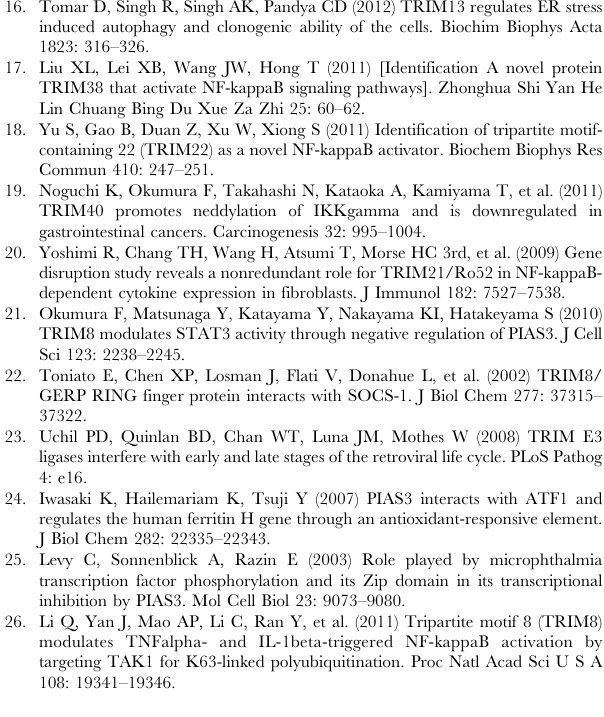
loaded for negative control of HA-TRIM8 and p65-GFP. Figure S3 TRIM8 overexpression increases clonogenic ability of HEK293 cells. TRIM8 and vector were transfected in HEK293 cells and clonogenic ability analyzed as described in materials and method section. Figure S4 RING domain and C-terminal region of TRIM8 is essential in regulation of clonogenic ability of cells. FL-TRIM8, D RING, D C-ter and vector were transfected in HEK293 cells and clonogenic ability analyzed as described in materials and method section.